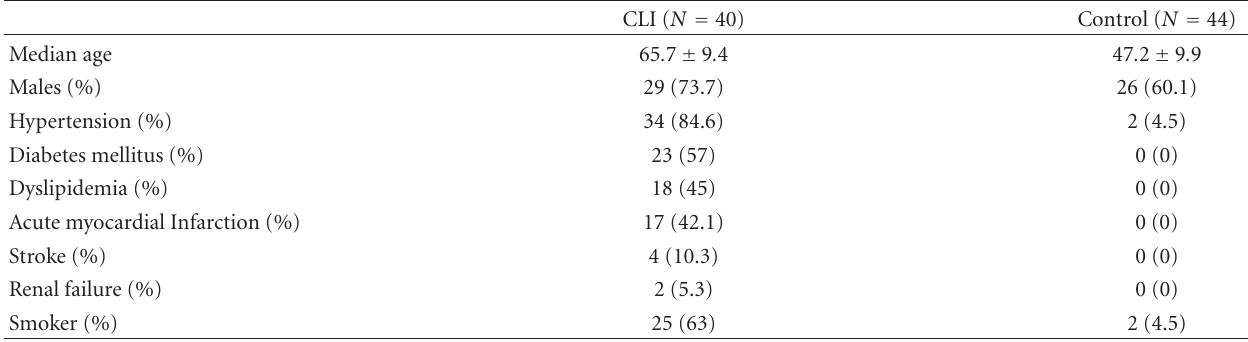
Table 1: Clinical and demographic characteristics of CLI and control